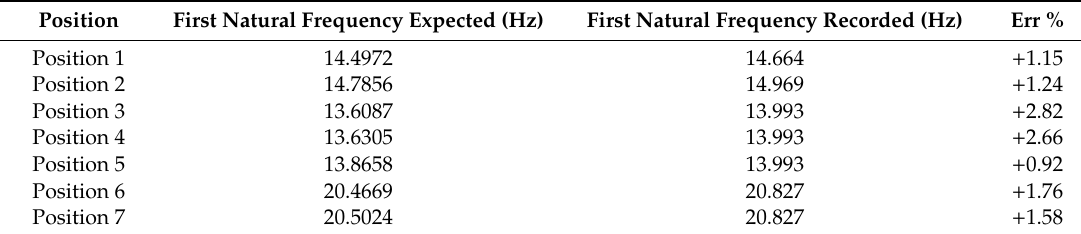
Table 1. Comparison of the first natural frequency in the seven reference positions obtained by applying a force with saturated ramp profile at the end e ff ector along x-axes (no damping).